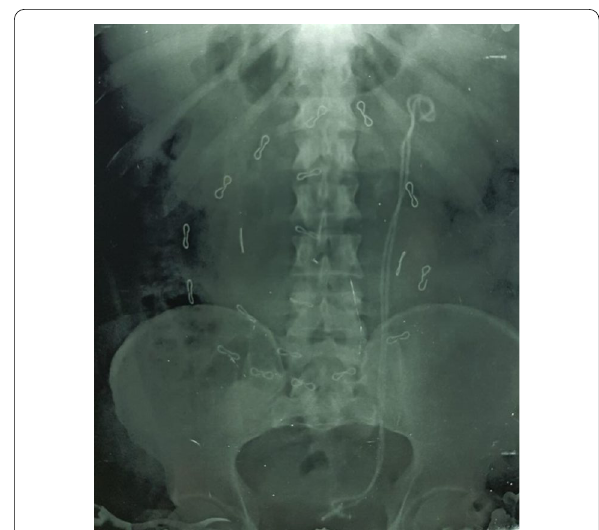
Fig. 1 Plain X ray reveals dual double J stents on the left urinary system covered with a layer of